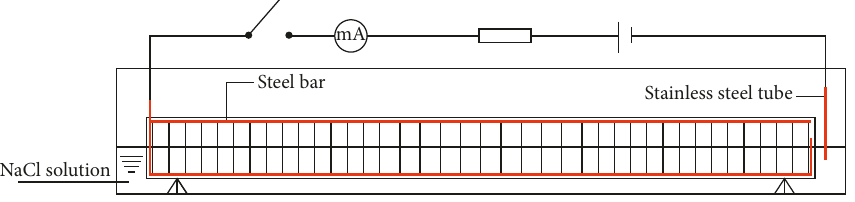
Figure 4: The accelerated corrosion